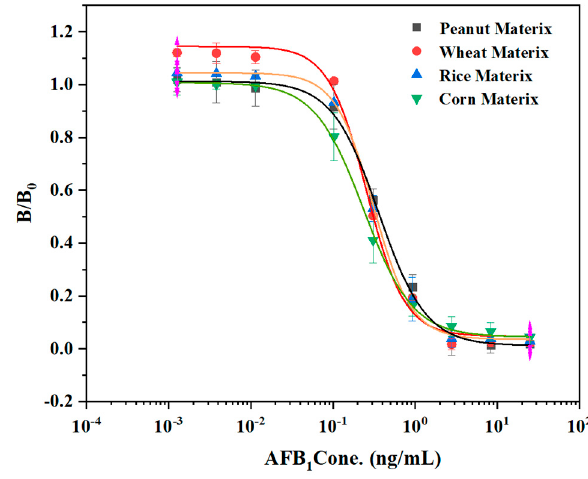
Figure 5. Assay standard curve of mercerized cotton in peanut, wheat, rice, and corn matrix.